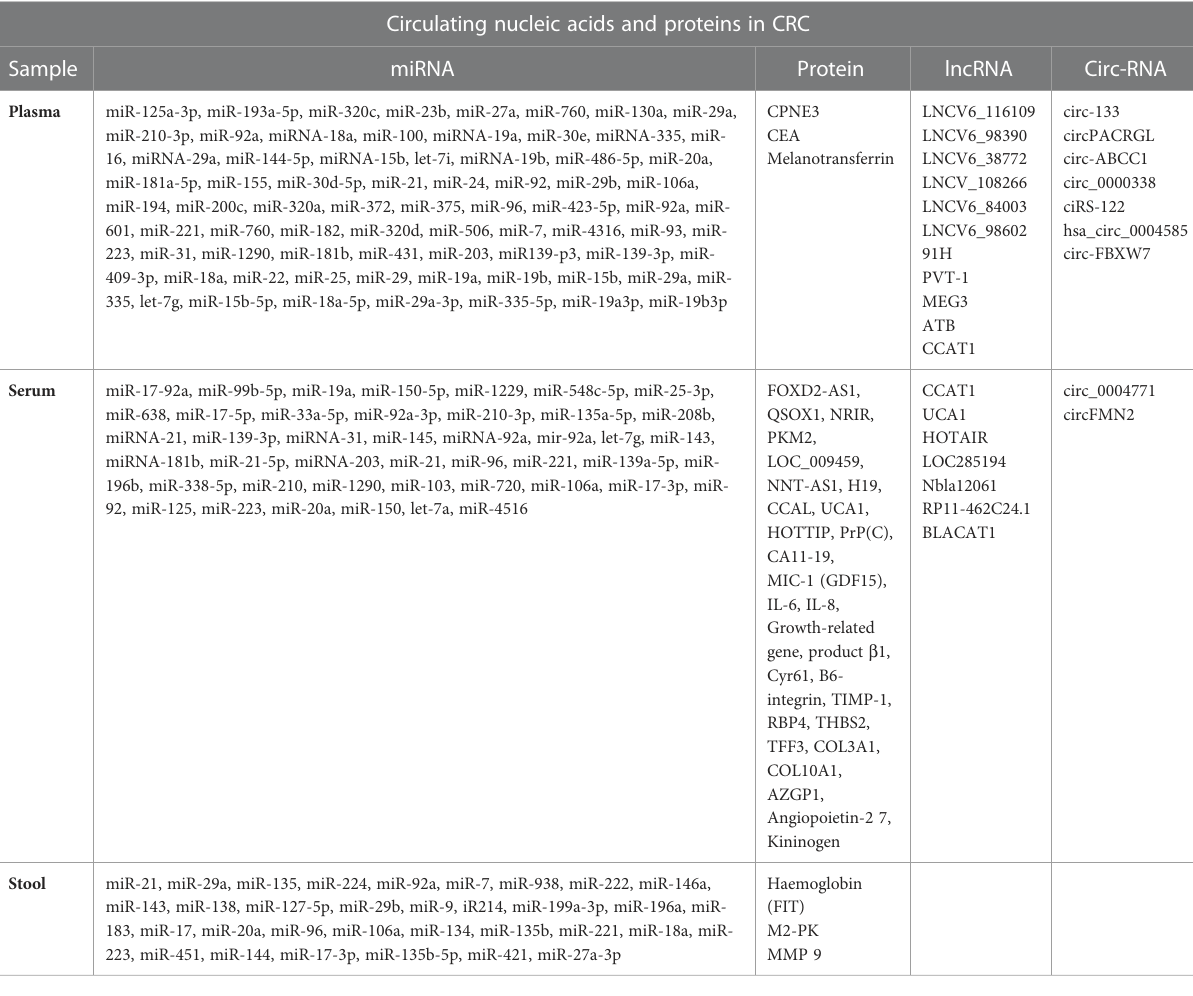
TABLE 2 Non-invasive biomarkers (miRNA, Proteins, lnc RNA and circ-RNA) used for CRC detection till date.